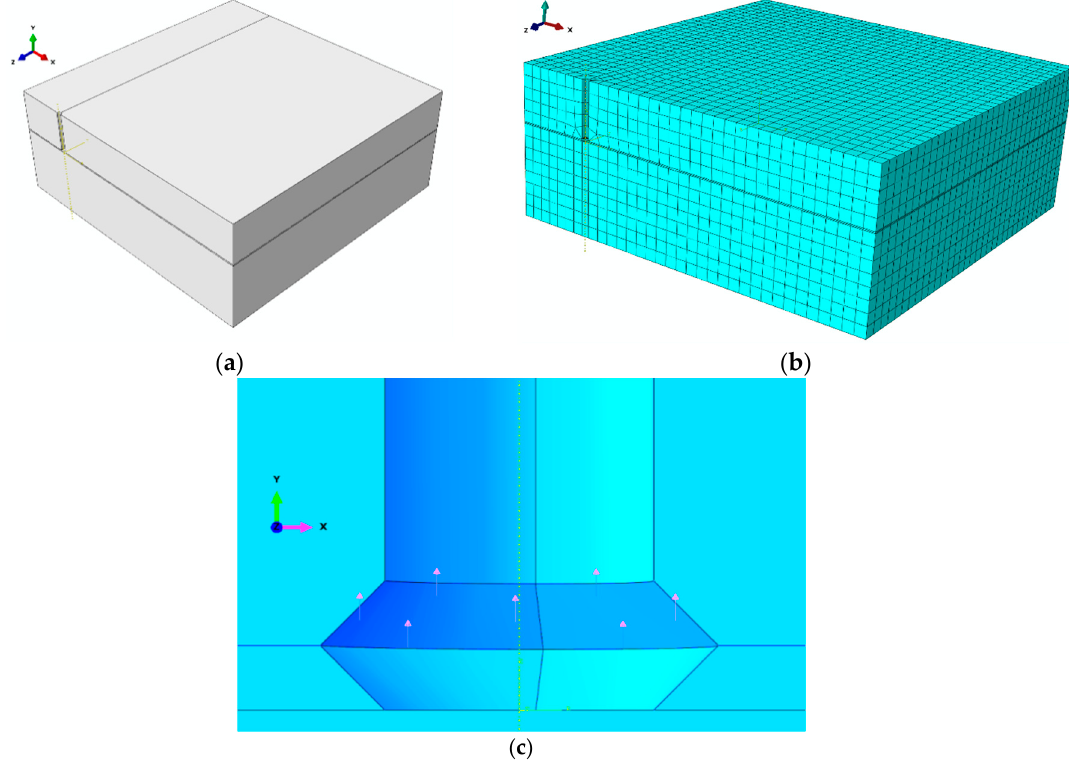
Figure 5. ( a ) A quadrant model for two anchors, ( b ) FEM mesh discretization, and ( c ) equivalent load for the interaction of the anchor cone on the base material.